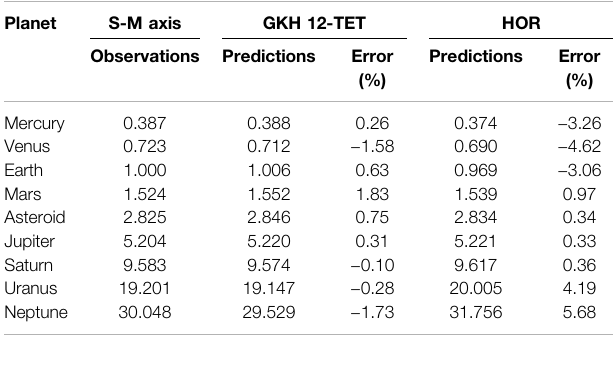
TABLE 6 | Mean predictions and relative errors in the semi-major axes of the planets of the Solar System relative to: (A) the Geddes – King-Hele 12-TET based model ( Eq. 13 ) herein proposed; (B) the harmonic orbit resonance (HOR) model by Aschwanden (2018) ( Eq. 21